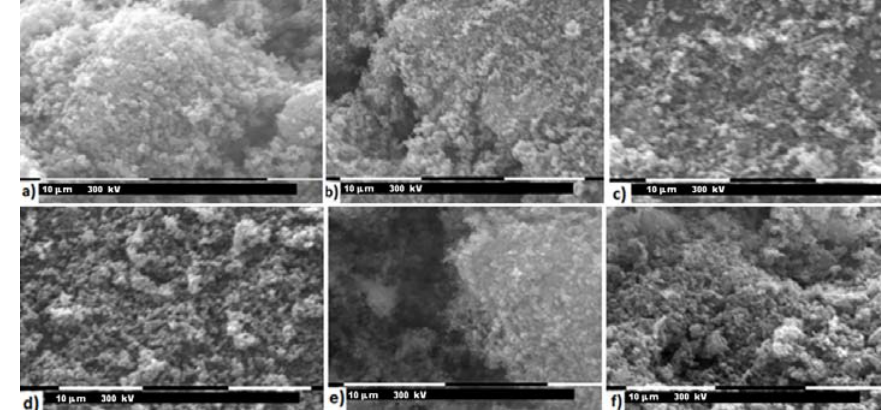
Figure 10. SEM images of: ( a ) LiFePO 4 ; ( b ) LiMn 0.05 Fe 0.95 PO 4 ; ( c ) LiMn 0.5 Fe 0.5 PO 4 ; ( d ) LiMn 0.9 Fe 0.1 PO 4 ; ( e ) LiMn 0.95 Fe 0.05 PO 4 ; and ( f ) LiMnPO 4 .